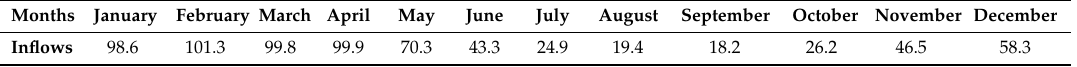
Figure 3. Maximum (in red) and mean (in blue) of the simulated inflow time series (2007–2016) from the LISFLOOD model for the studied reservoirs in the Iberian Peninsula. Table 1. Average monthly inflows (m 3 / s) for the ensemble of reservoirs for 2007–2016 study period.